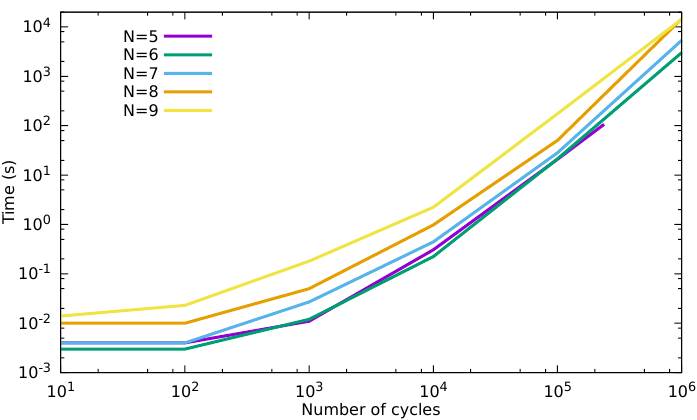
Figure 7. Exec times (s) in function of the number of generated GCs for different dimensions of N